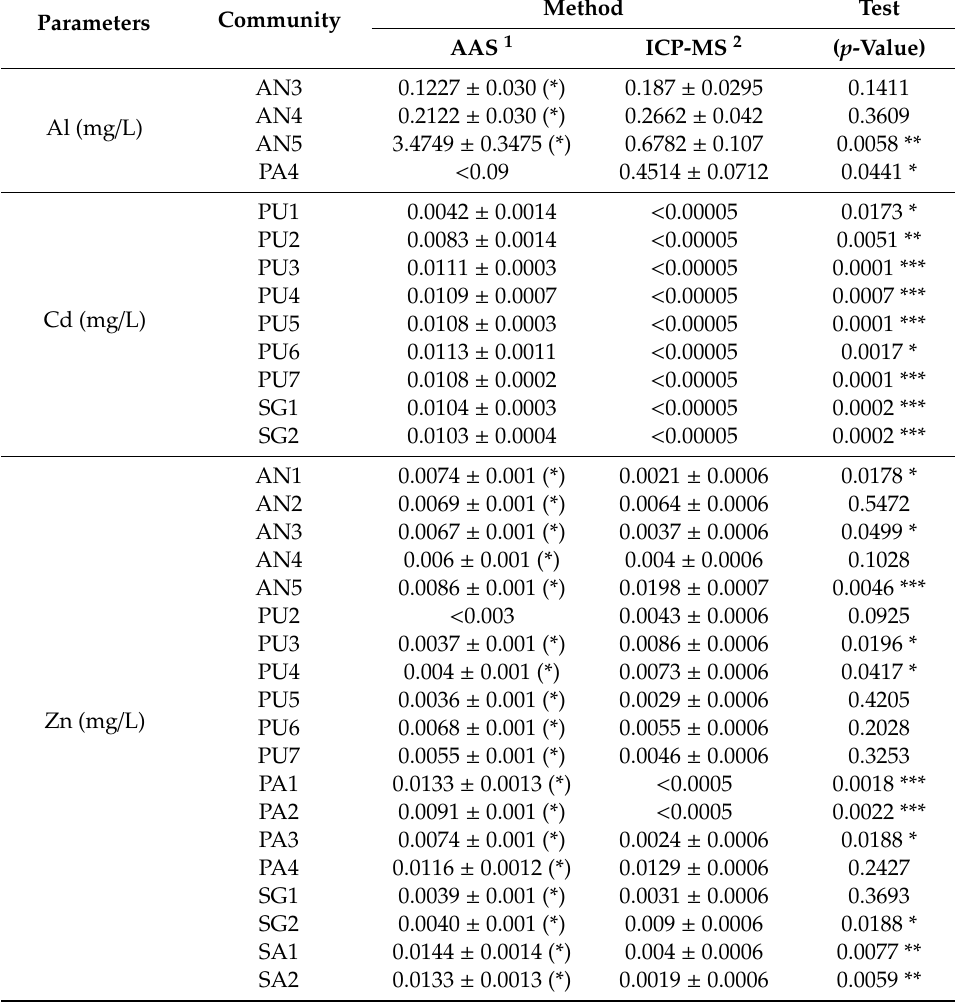
Table 7. Comparison of di ff erent analysis techniques for Al, Cd, and